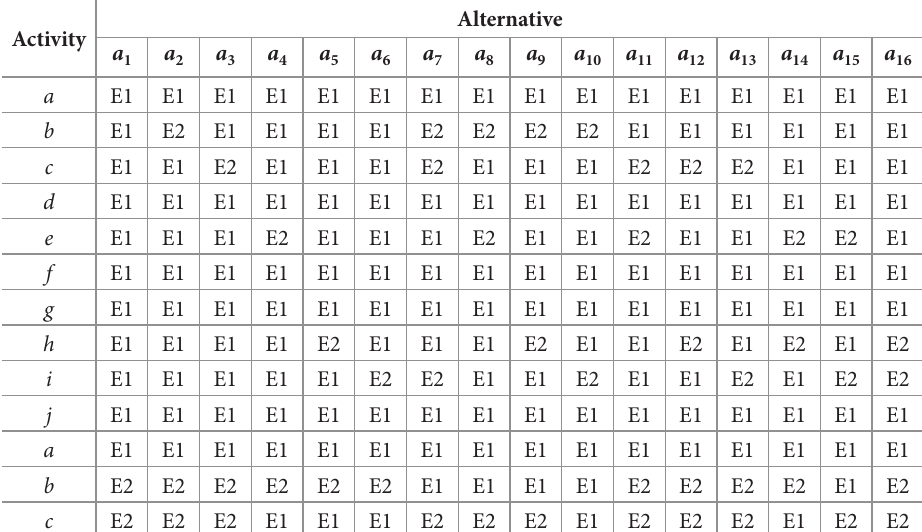
Table 2. The set of